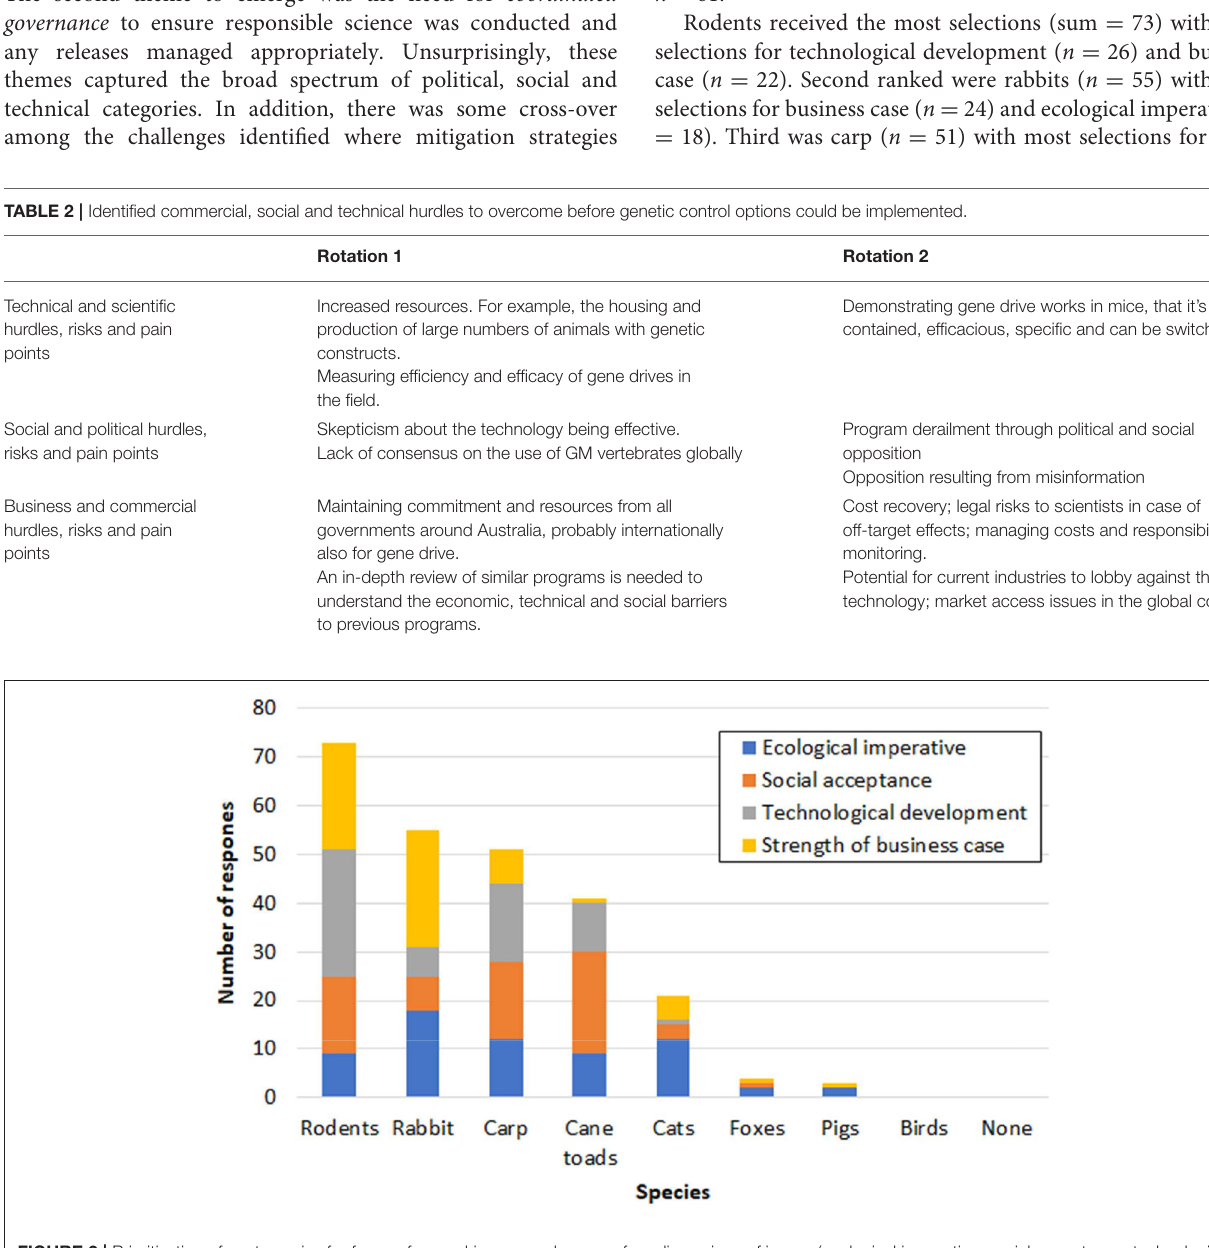
FIGURE 2 | Prioritization of pest species for focus of gene drive research across four dimensions of issues (ecological imperative, social acceptance, technological development and business case). Workshop participants selected two species for each issue. Each bar represents the sum of selections by workshop participants for each